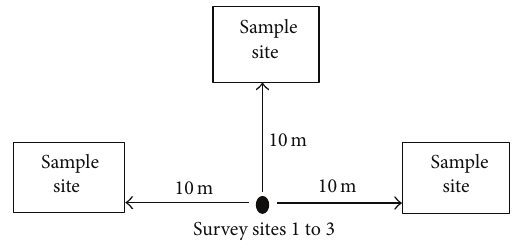
Figure 1: Placement of the sample sites at each of the three survey sites located within the Central Sandy Bushveld on Kwalata Game Ranch.